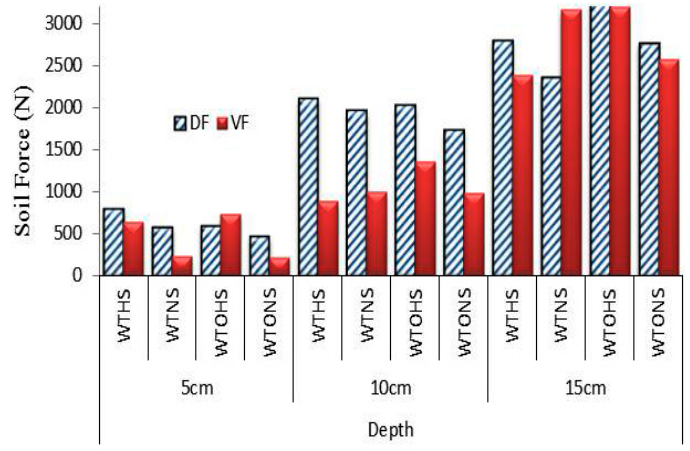
Figure 2. Soil force at 30% water content and tool parameters with different straw conditions and different depths. WTNS: plow with a trash-board in stubble condition; WTONS: plow without a trash-board in stubble condition; WTHS: plow with a trash-board in dense straw cover; WTOHS: plow without a trash-board in dense straw cover (WTOHS).